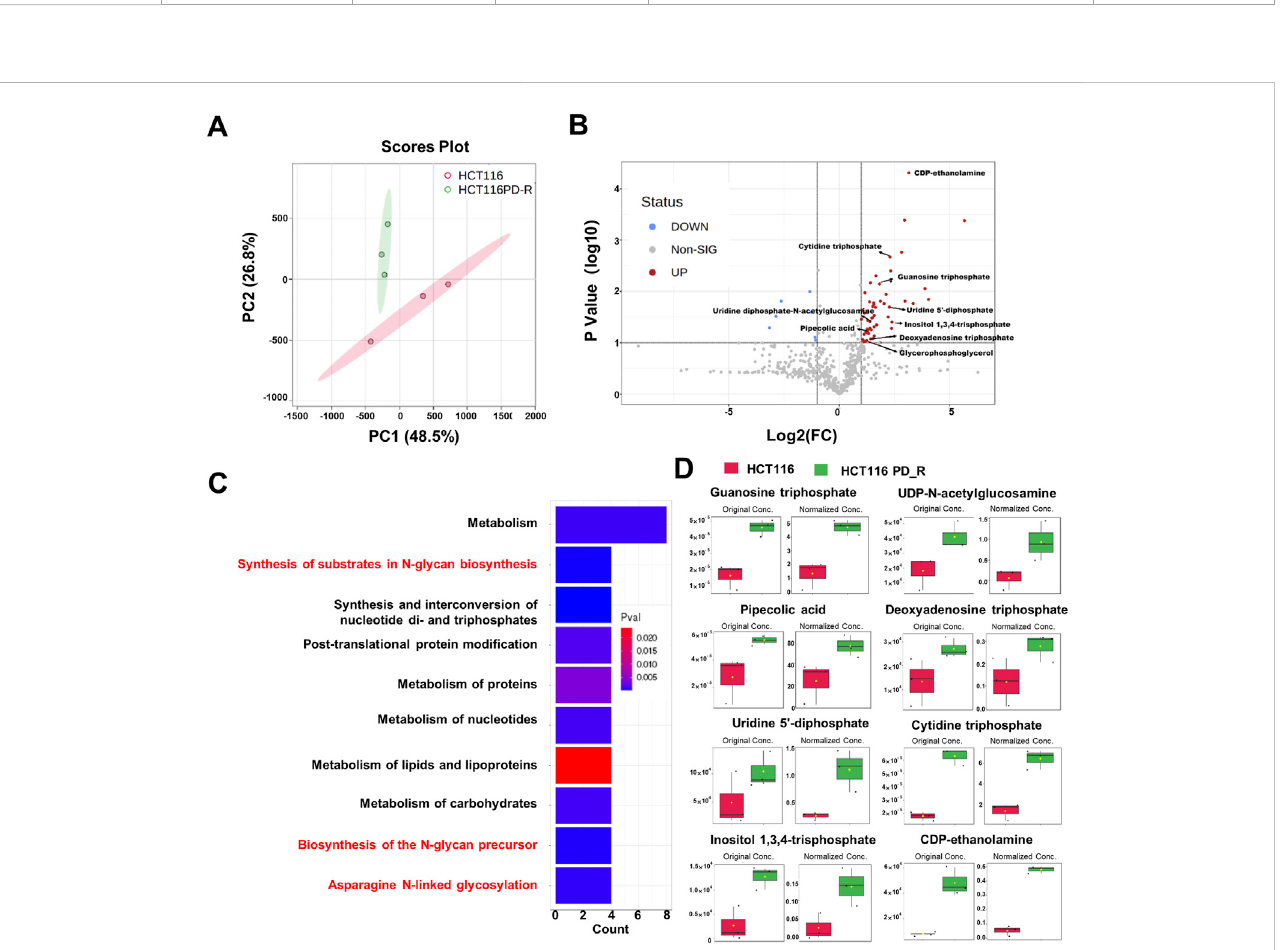
FIGURE 3 Metabolomics analysis of HCT116 and HCT116 PD_R cells. (A) Score plots of PCA models for the metabolome data obtained by LC-MS, showing the metabolic pro fi le differences between HCT116 and HCT116 PD_R. Red cycle: HCT116 PD_R; Green cycle: HCT116. (B) Volcano plot of metabolomic data constructed using Fold Changes (HCT116 PD_R/HCT116) and adjusted p -values (FC > 2, p -value < 0.05). (C) Top ten enriched KEGG pathways of the upregulatedmetabolites. (D) Signi fi cantlyupregulatedmetabolitesamongtheHCT116andHCT116PD_Rcells.Thebarplotsontheleftshowtheoriginal peak intensity values (mean ± SD). The bars on the right present the normalized